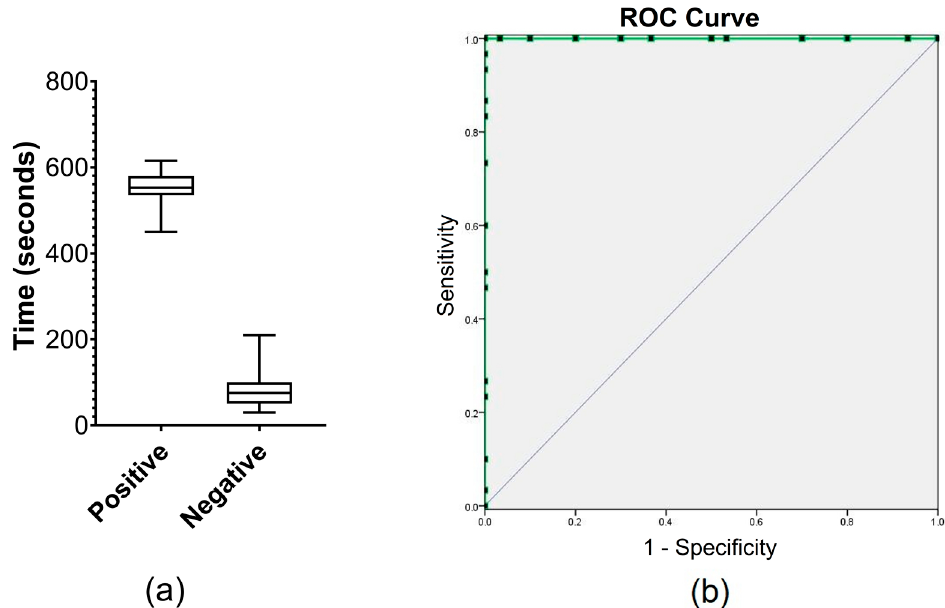
Figure 3. E-phase threshold determination. ( a ) Comparison between LD-qPCR positive and LD-qPCR negative samples in E-phase duration (in seconds) of Q-RPA. ( b ) Receiver-operating-characteristic curve (AUC = 1.00, p < 0.0001) for E-phase as the predictor of positive results by Q-RPA. Coordinates of the curve (green) are indicated by black dots.